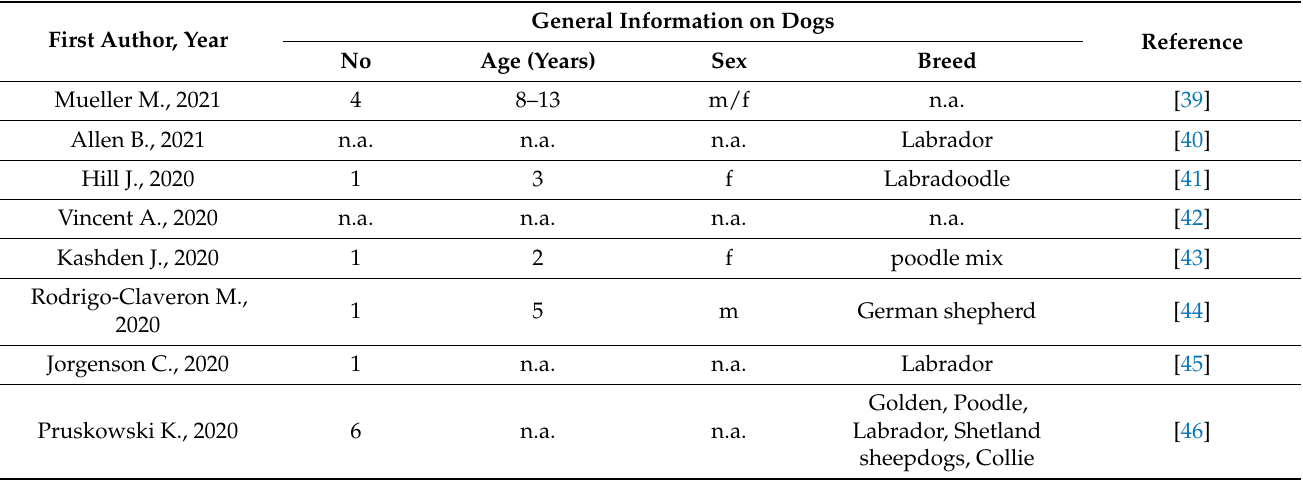
Table 1. Results of general information regarding dogs involved in the included